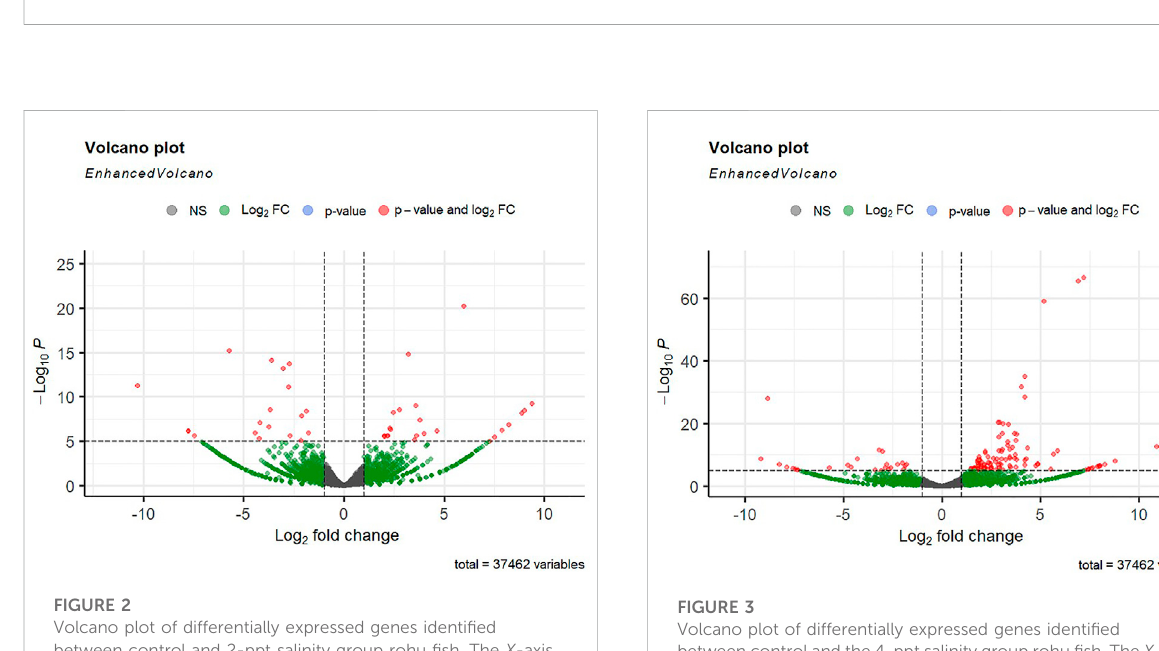
FIGURE 3 Volcano plot of differentially expressed genes identi fi ed between control and the 4-ppt salinity group rohu fi sh. The X -axis signi fi es the Log2 fold change value, and the Y -axis indicates the − Log10 p value. The ash color dots indicate no signi fi cant difference between the two groups. The green dots indicate moderately signi fi cant and red dots highly signi fi cant differential